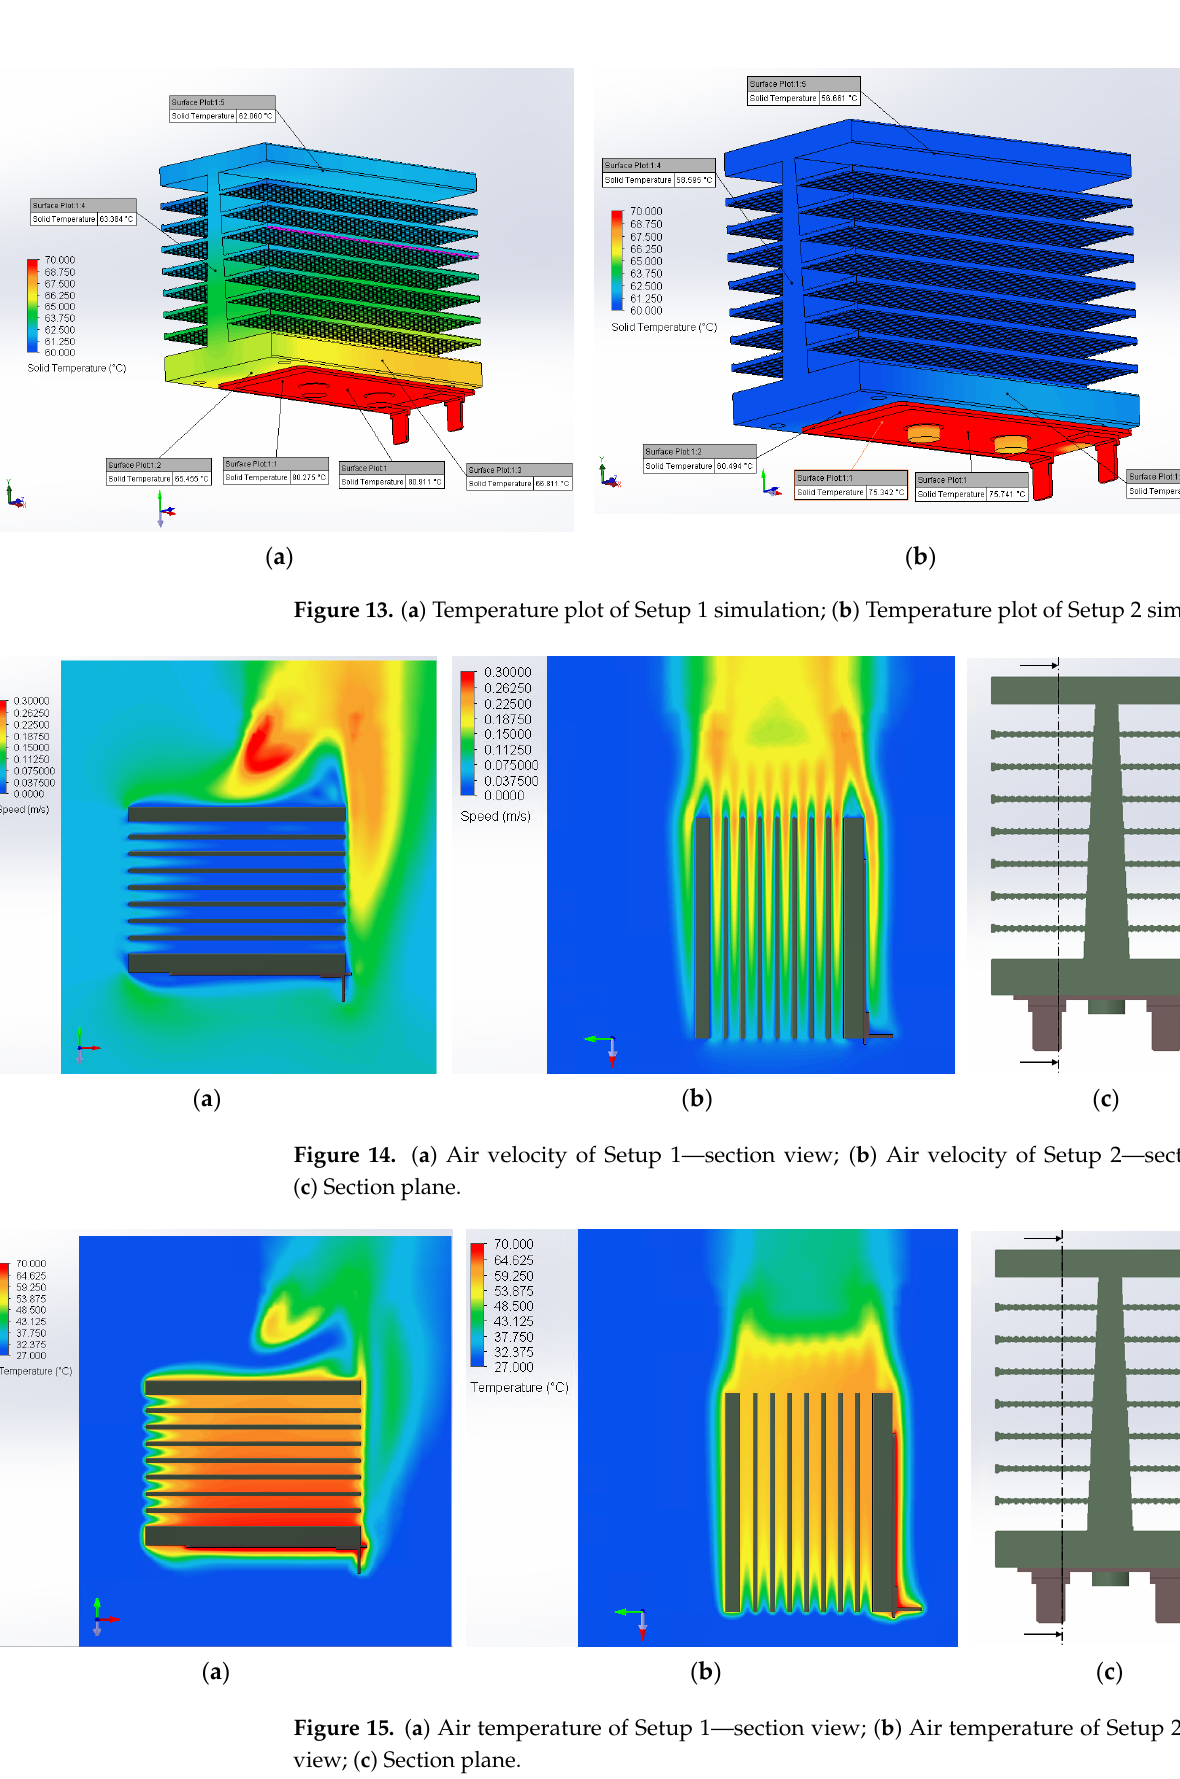
Figure 15. ( a ) Air temperature of Setup 1—section view; ( b ) Air temperature of Setup 2—section